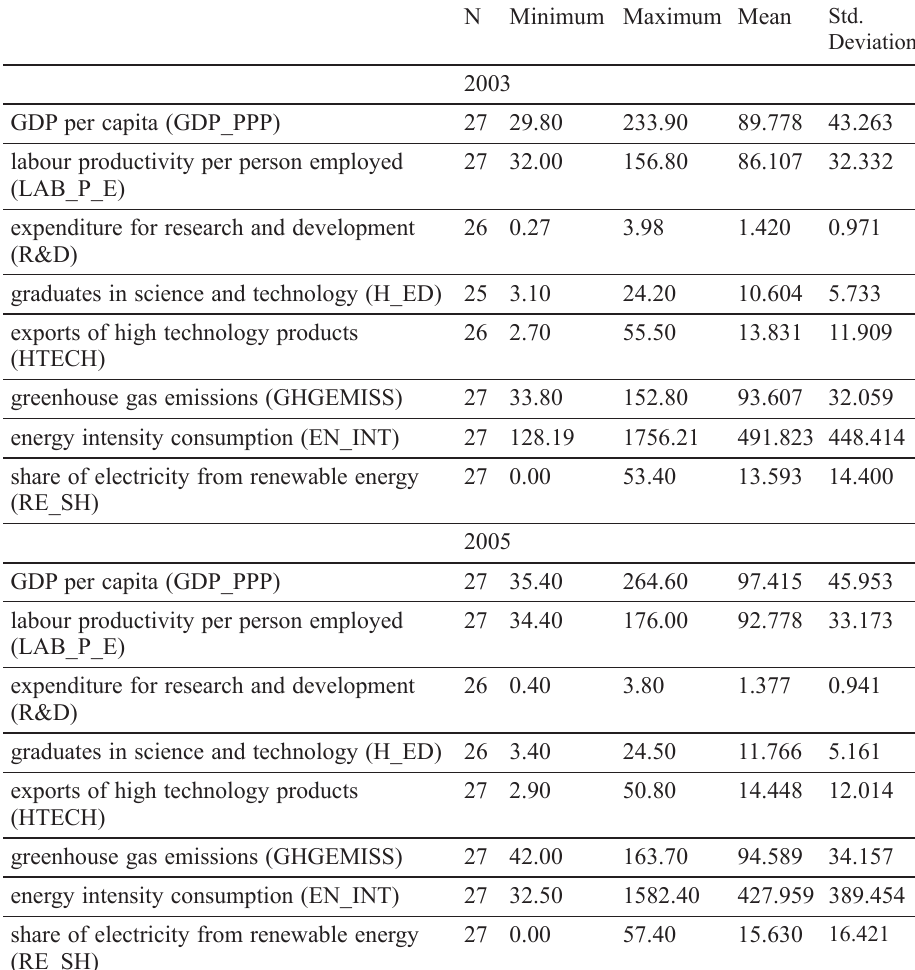
Table 4. Descriptive statistics of the analyzed structural indicators’ variables for the EU-27 countries in 2003 and 2005 N Minimum Maximum Mean Std.